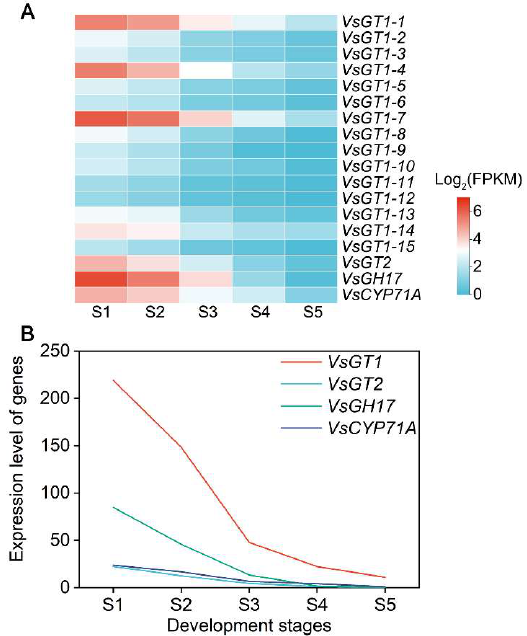
Figure 8. The expression levels of ( A ) key regulatory genes and ( B ) key regulatory gene